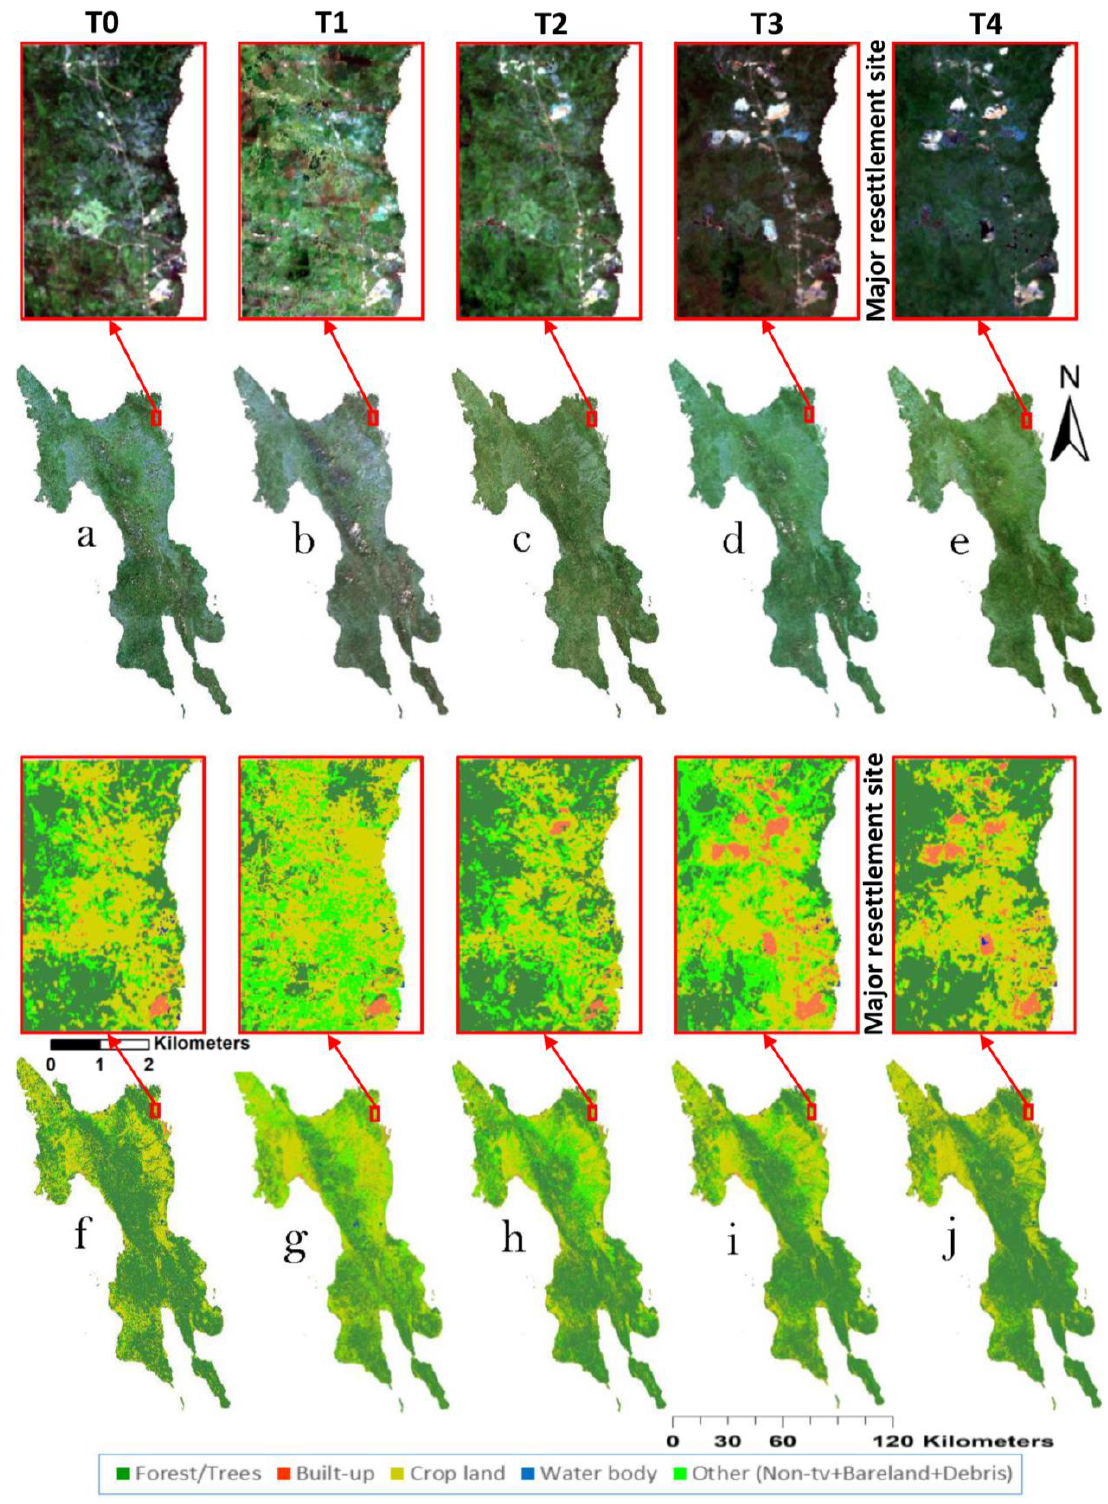
Figure 3. ( a – e ) Landsat image composites acquired over Leyte island for T0–T4 times, respectively, (f – j) land cover classification maps produced with GEE for T0–T4 times, respectively. Red rectangles show the status of the relocation site (northern part of Tacloban) for T0–T4 times. Non-tv—Non-tree vegetation.